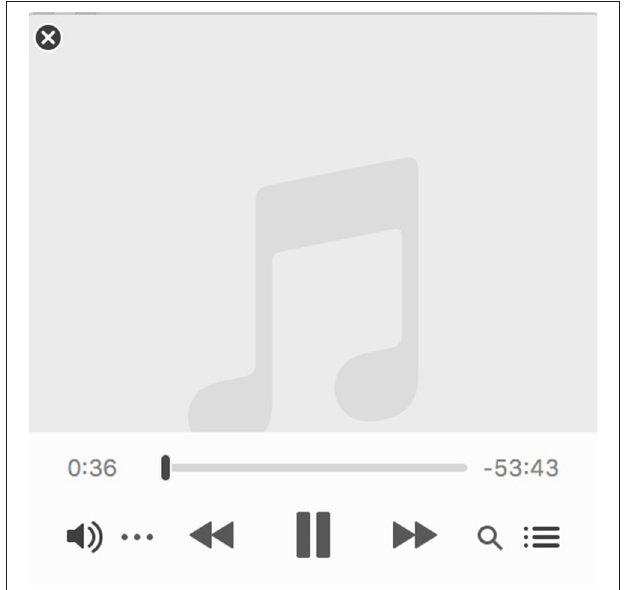
FIGURE 4 | Clickable audio providing the “northern elephant symphony,” a sonification of data on movement across the Northeastern Pacific Ocean of northern elephant seals monitored from 2004 to 2014. Pitch represents the degrees longitude from the rookery (high pitch represents animals closer to the rookery, and low pitch animals moving into the Northeastern Pacific Ocean far away from the rookery), for each of the animals traveling as a group, while volume represents the spatial spread of the animals (i.e., loud music represents a compact group of animals traveling together). Available online at: